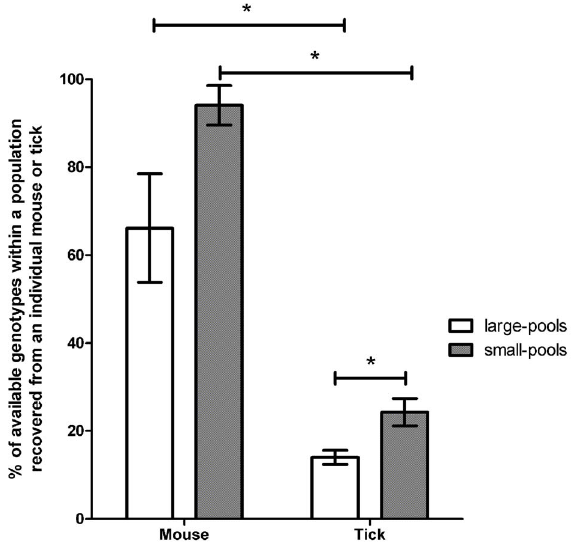
Figure 1. Retention of genotypic diversity in hosts or vectors exposed to large- or small-genotype pools. The mean proportion of genotypes recovered from individual mice or individual ticks were compared between conditions of high and low genotypic diversity. Individual mice exposed to either large- or small-genotype pools were colonized by a significantly greater proportion of genotypes than individual ticks. The proportion of genotypes retained was significantly reduced in ticks exposed to large-genotype pools as compared to ticks exposed to small-genotype pools. Error bars represent 6 SEM.